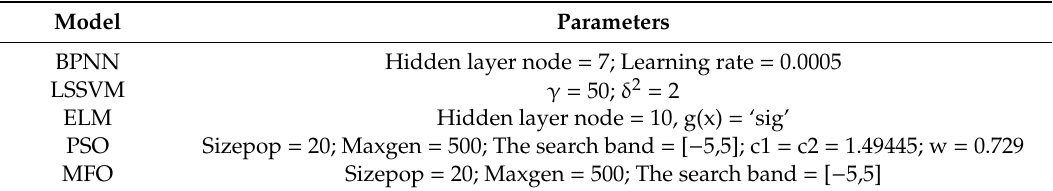
Table 5. Parameters of the proposed model and its comparison models